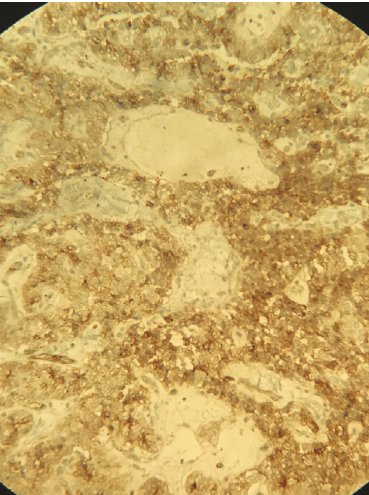
Figure 6: Immunohistochemical staining for CD10, showing mem- branous staining in the tumor cells.